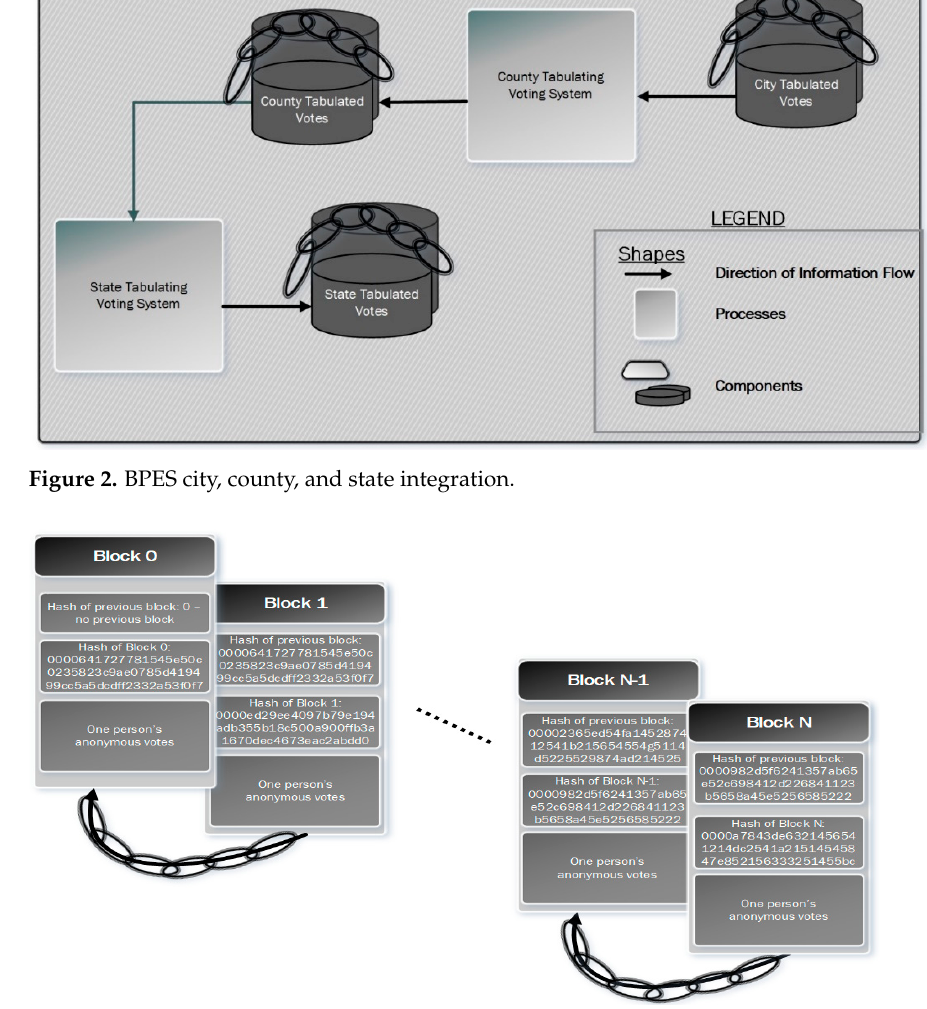
Figure 3. An example of the BPES blockchain.